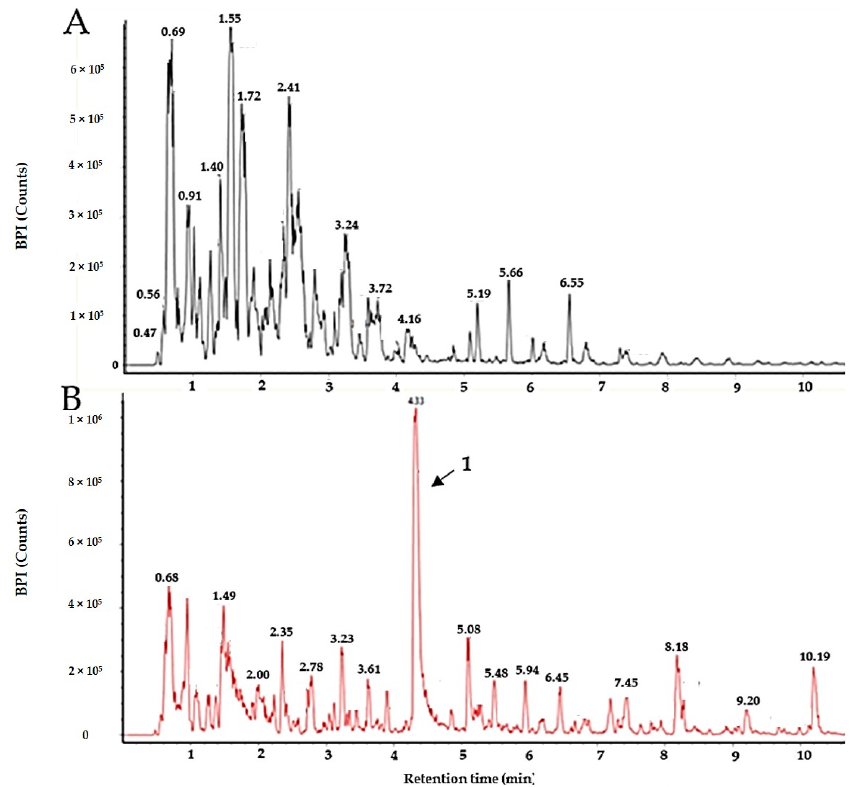
Figure 6. BPI chromatograms of the extracts of two co-cultures. ( A ) The extract of a 14-day culture (10 ◦ C) supplemented with 160 µ M Fe(III). ( B ) The extract of a 14-day culture (10 ◦ C) grown in iron-deficient media. The peak of serratiochelin A ( 1 ) is indicated by the black